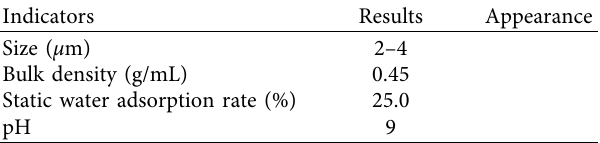
Figure 1: Triethylenediamine. Table 3: Technical indicators of the 5A molecular sieve. Table 5: Technical indicators of granite